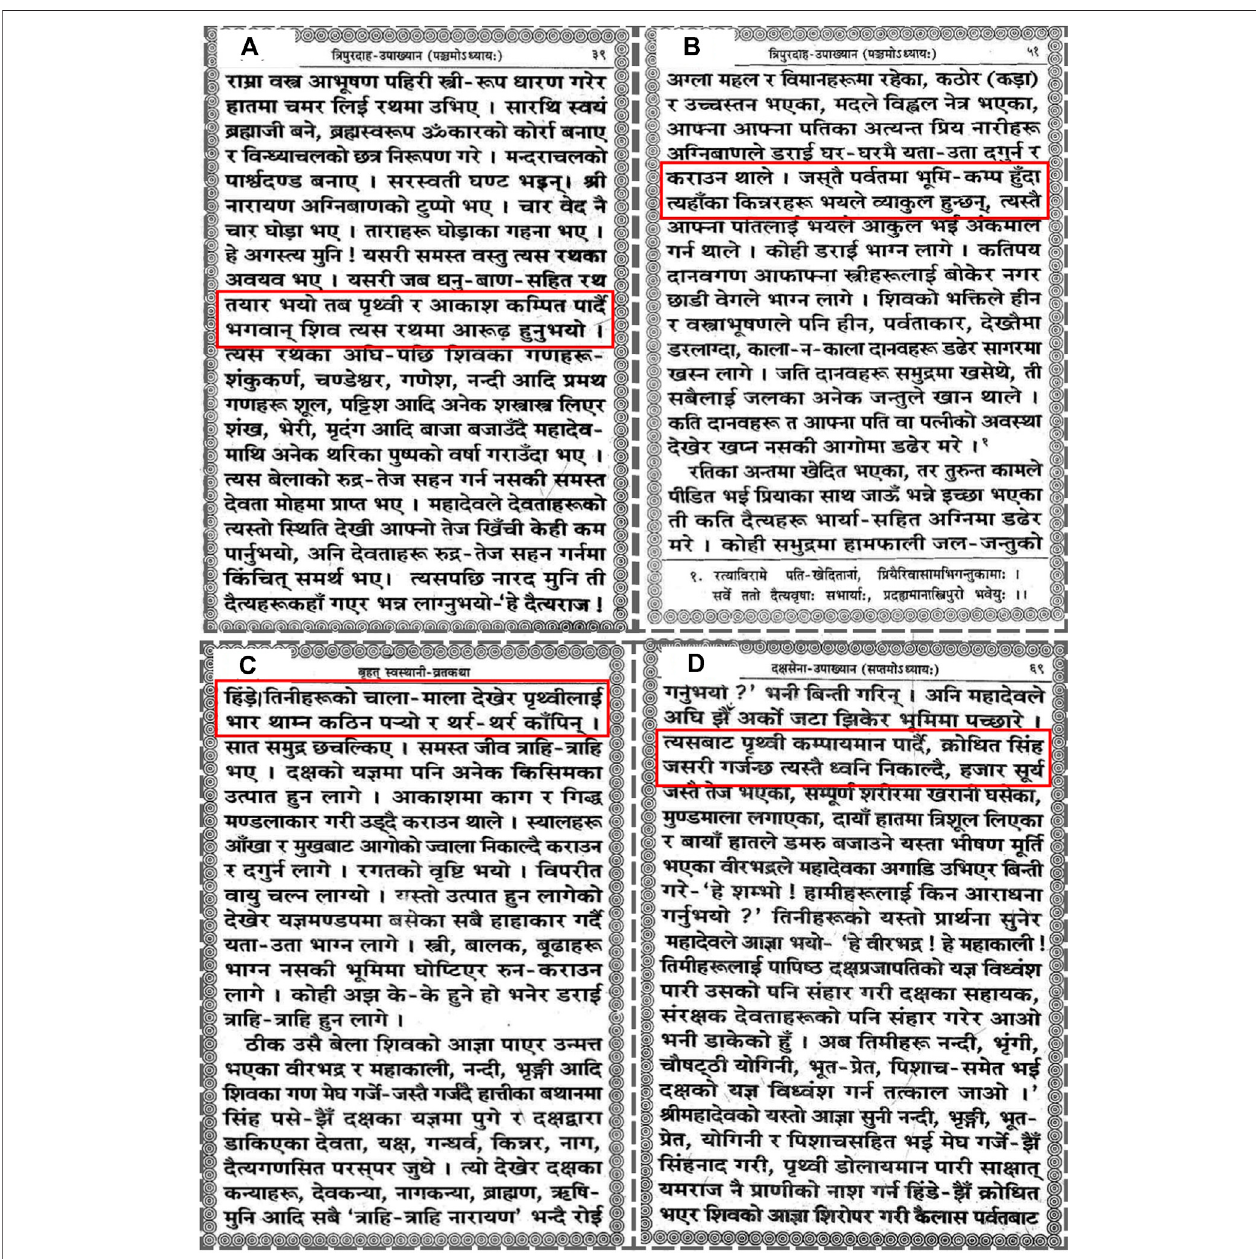
FIGURE4| Evidencesofearthshakingfoundin SwasthaniBrataKatha (2020).Redrectanglesisdrawntohighlighttheexacttextwheretheword “ earthtremble ” or “ earth shaking ” or “ earthquake ” is written.